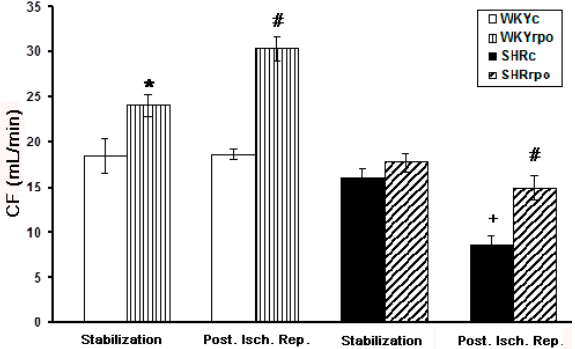
Figure 4. Effect of dietary red palm oil (RPO) supplementation on the coronary flow (CF) of WKY and SHR during stabilization and post ischemic reperfusion (Post. Isch. Rep). WKYc—Wistar Kyoto control rats; WKYrpo—WKY rats treated with RPO; SHRc—Spontaneously hypertensive rats; SHRrpo—SHR treated with RPO; Results are expressed as mean ± SEM; n = 6 in each group; * p < 0.05 versus control rats (WKYc); # p < 0.05 WKY/SHR versus treated with RPO; + p < 0.05 SHRc during stabilization versus SHRc during Post. Isch. Rep.